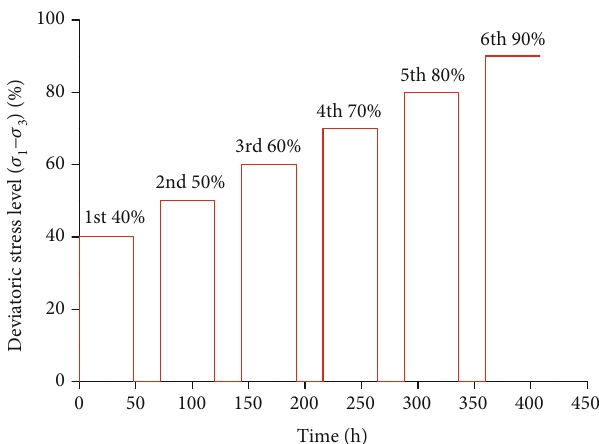
Figure 5: Multilevel loading and unloading process for triaxial creep